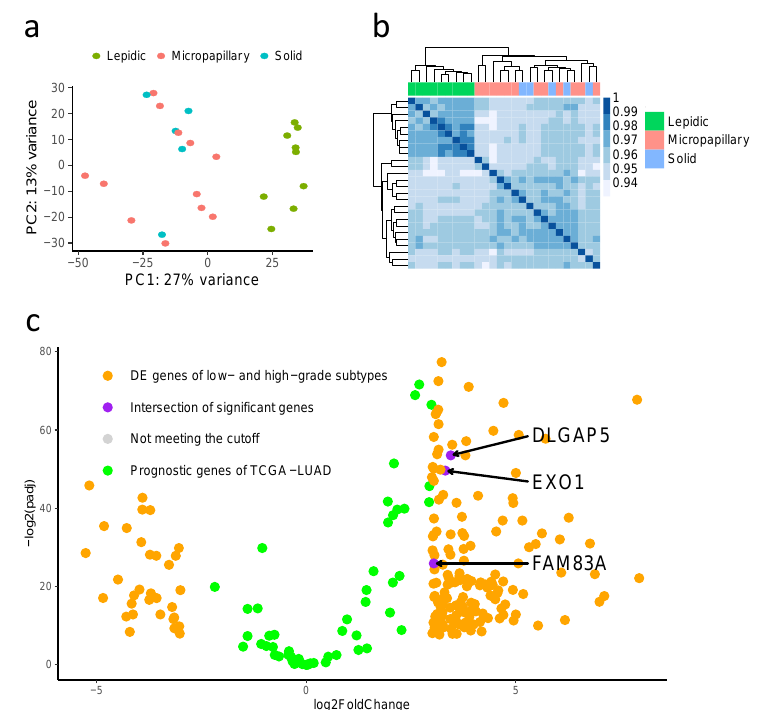
Figure 3. Differentially expressed genes. ( a ) Principal component analysis and ( b ) pairwise correlation analysis identified two distinct clusters associated with morphological subtypes. ( c ) Intersection of significant differentially expressed genes and The Cancer Genome Atlas-Lung Adenocarcinoma prognostic